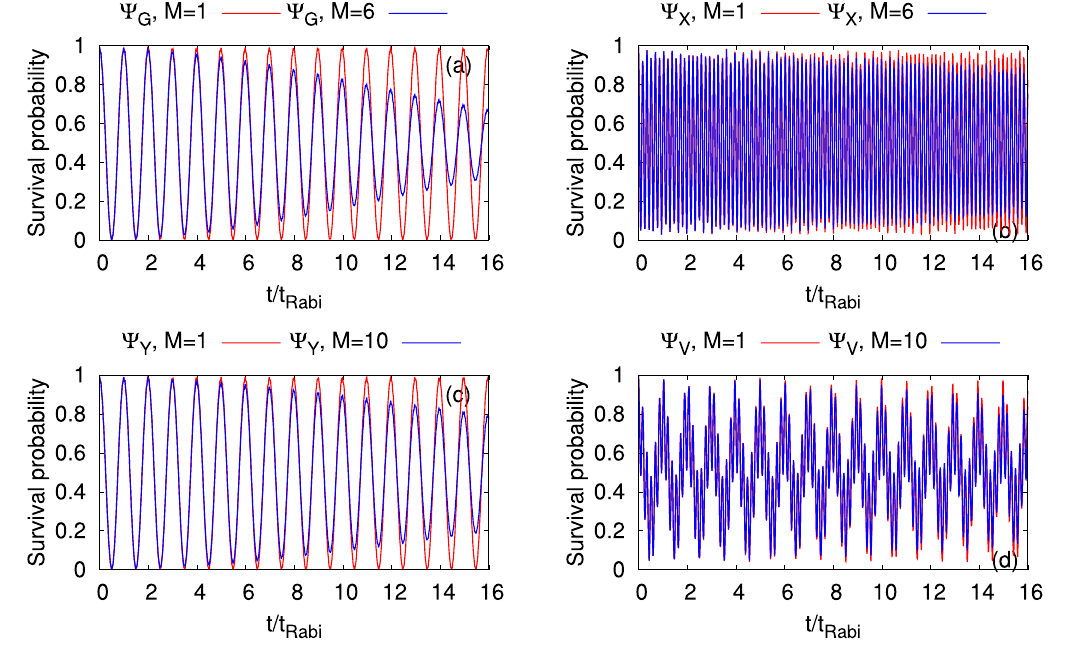
Figure 2. Time evolution of the survival probability in the left well, P L ( t ) , of a symmetric 2D double-well potential for the initial states ( a ) (cid:31) G , ( b ) (cid:31) X , ( c ) (cid:31) Y , and ( d ) (cid:31) V . Mean-field results are in red solid line and 0.01 π and the number corresponding many-body results are in blue solid line. The interaction parameter is � = 10 . The many-body time evolutions are computed using the MCTDHB method with M 6 of bosons is N = = 10 time-adaptive orbitals for (cid:31) time-adaptive orbitals for (cid:31) G and (cid:31) X and M Y and (cid:31) V . See the text for more = details. The quantities shown are